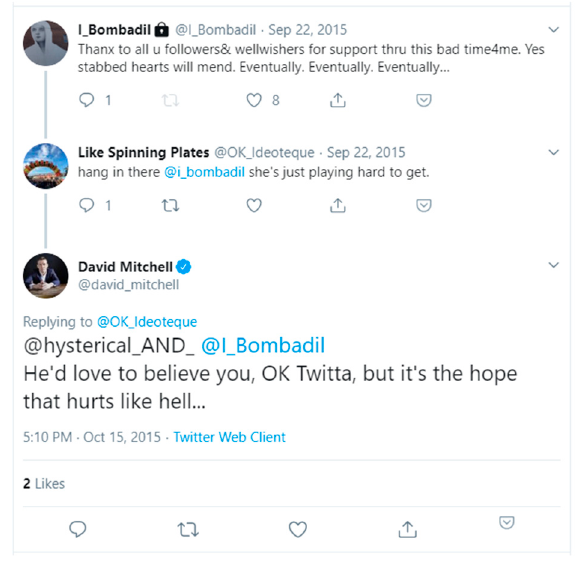
Figure 2. @david_mitchell replies to @I_Bombadil’s tweet.